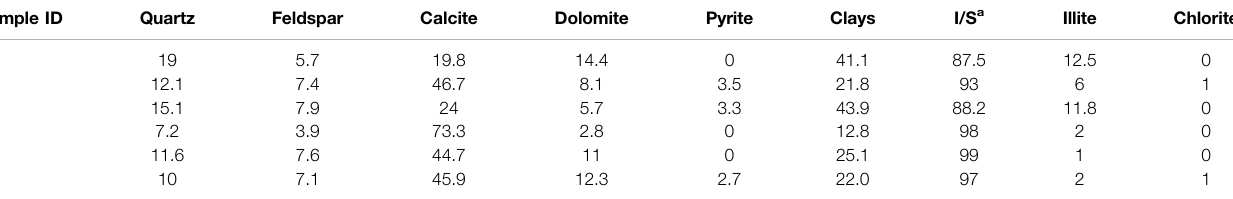
TABLE 2 | Mineral composition in weight percentage (%).